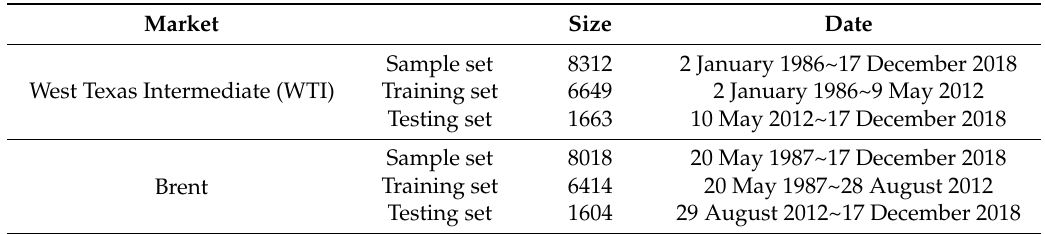
Table 1. Samples of crude oil